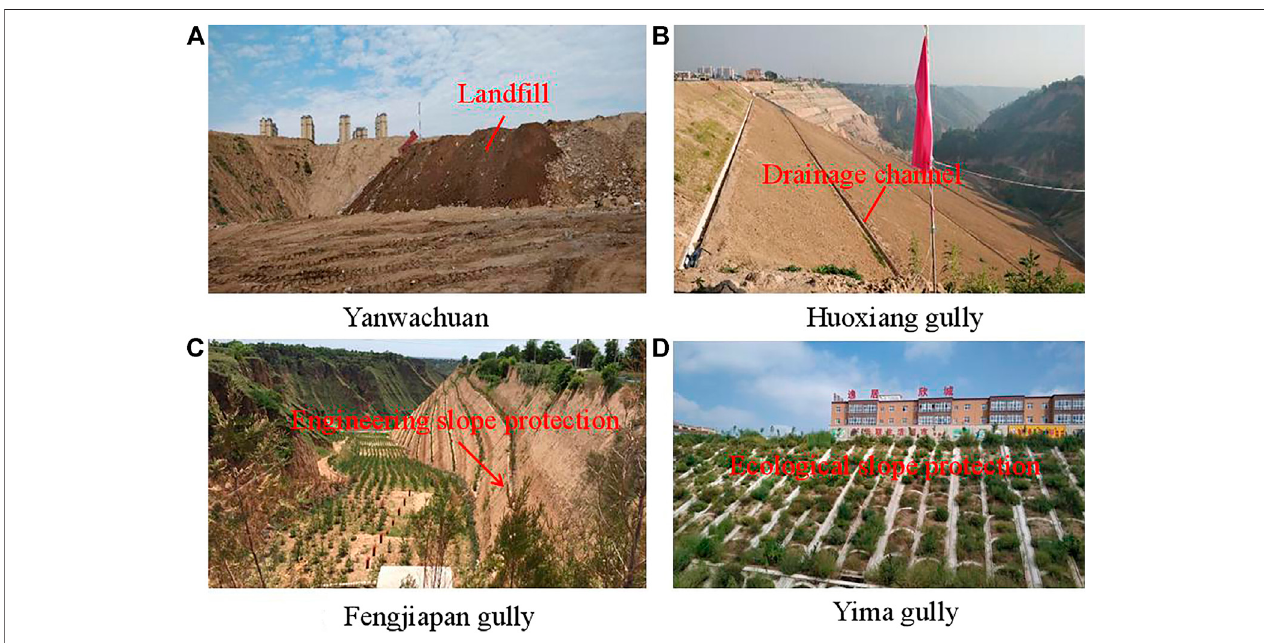
FIGURE 6 | Photographs of different traceable erosion management